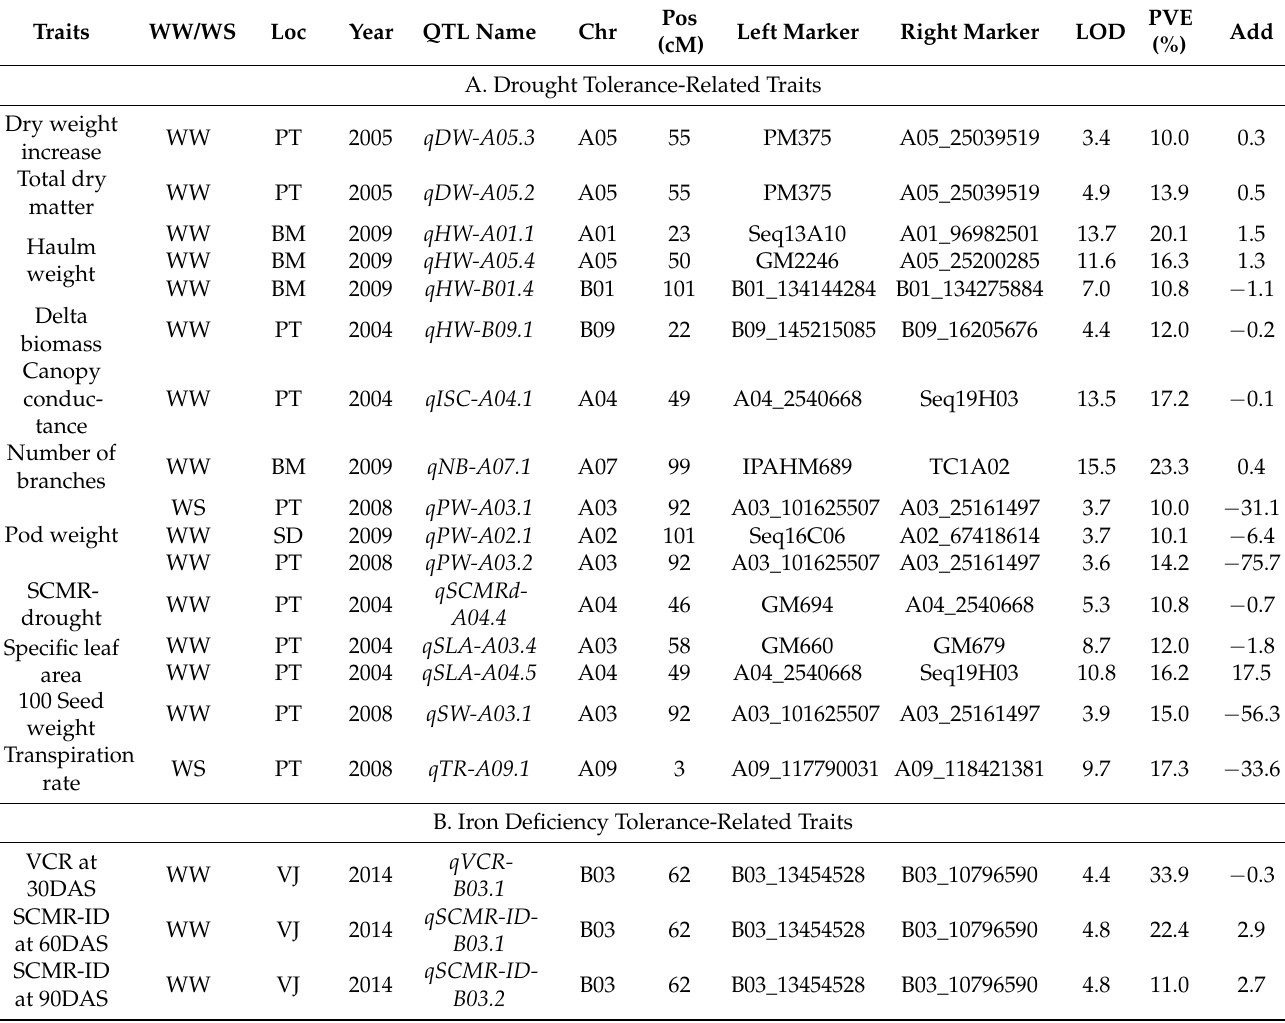
Table 4. Major main-effect QTLs for drought tolerance- and iron deficiency tolerance-related